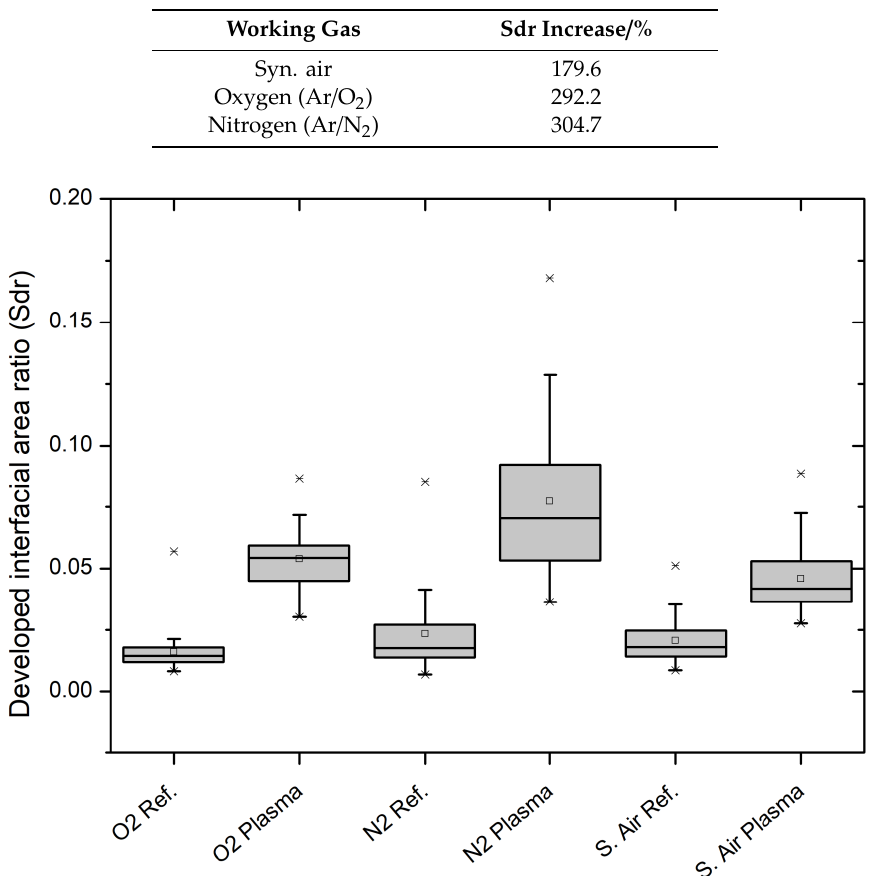
Figure 5. Developed interfacial area ratio (Sdr) of references and plasma treated PP60 specimens.